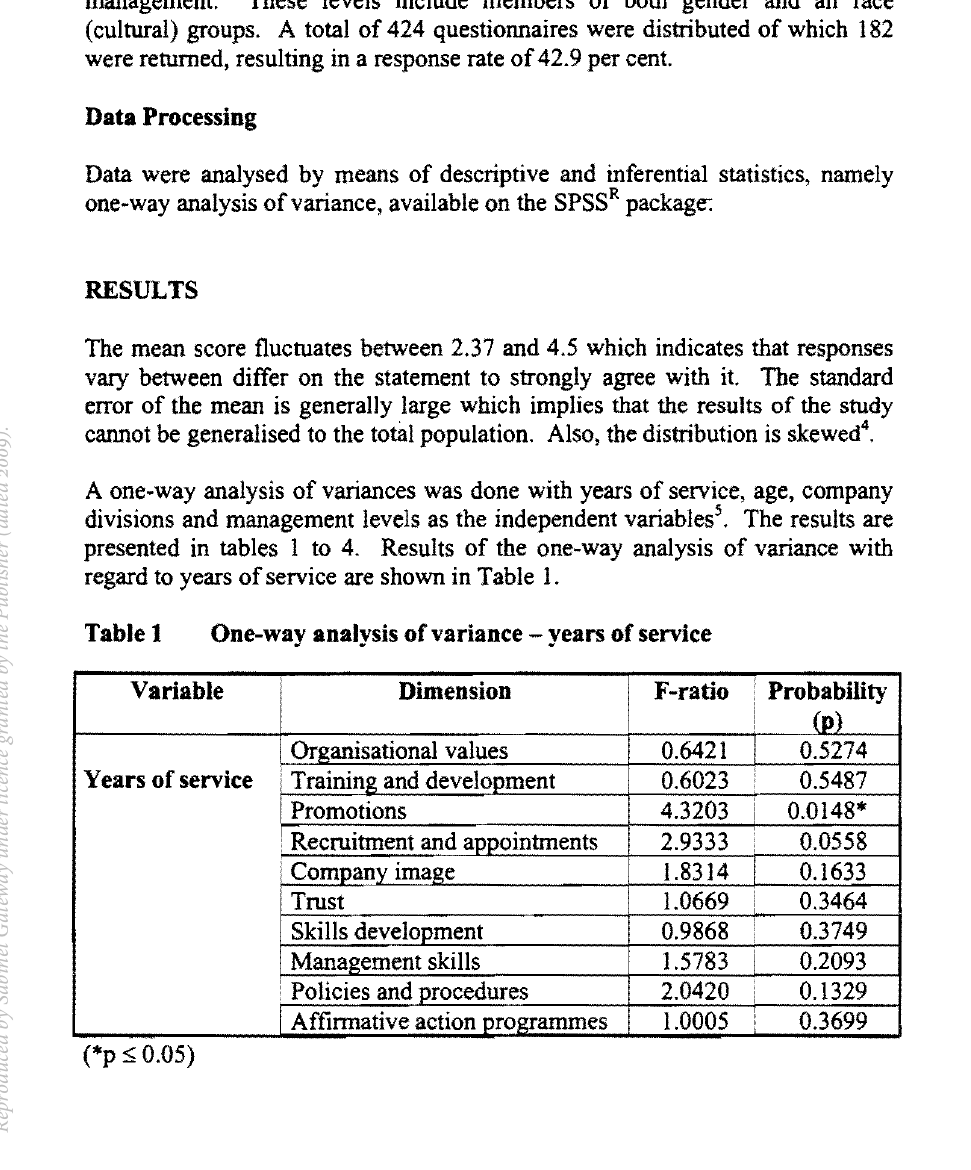
One-way analysis of variance - years of service